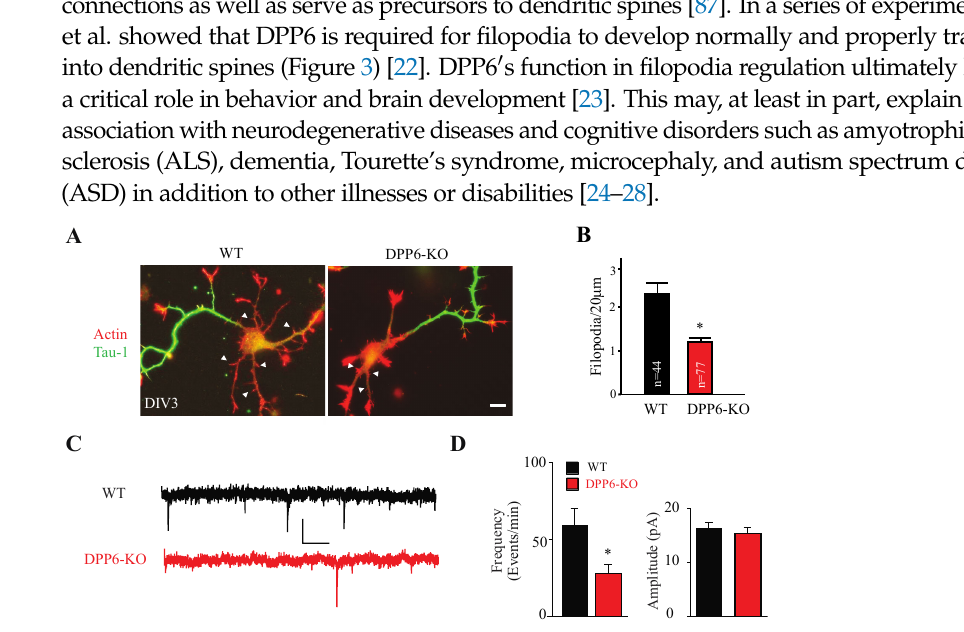
Figure 3. Dendritic filopodia formation is reduced in DPP6 ‐ KO hippocampal neurons and res ‐ cued by DPP6 expression. ( A , B ) DIV3 WT or DPP6 ‐ KO hippocampal neurons visualized for actin filaments with TRITC ‐ phalloidin (red) and for axons with marker Tau ‐ 1 (green). The density of im ‐ mature dendritic filopodia (arrowheads) is decreased in the DPP6 ‐ KO neurons compared to the WT. Scale bars = 10 μ m. ( C ) Sample mEPSC traces from WT and DPP6 ‐ KO cultured hippocampal neu ‐ rons recorded at DIV14 and 15. Scale bars: 10 pA, 250. ( D ) Average mini frequency is decreased in DPP6 ‐ KO versus WT cultured hippocampal neurons, whereas amplitude is not affected. Error bars represent the mean ± SEM. * p < 0.05. From Figures 1 and 3 in Lin et al., 2013 [22]. To show the connection between filopodia and DPP6, Lin et al. [22] first quantified the density of immature dendritic filopodia in cultured hippocampal neurons from DPP6 ‐ KO and WT mice at DIV3. There was a ~45% reduction in DPP6 ‐ KO compared to WT, and a significant decrease in immature dendritic filopodia density (Figure 3A,B). When ex ‐ pressing GFP ‐ tagged DPP6 (DPP6 ‐ GFP), there was a significant increase in immature den ‐ dritic filopodia compared to the expression of GFP alone. To better understand how DPP6 influenced the number of filopodia, they measured filopodia in live imaging experiments. The average life span of existing filopodia was significantly reduced in DPP6 ‐ KO neurons. After transfecting DPP6 ‐ GFP into DPP6 ‐ KO neurons at P0, filopodia stability was rescued. While monitoring the stability of filopodia, the number of new filopodia formed was also counted, showing that DPP6 ‐ KO neurons produce ~60% fewer filopodia than WT neu ‐ rons. Transfecting the DPP6 ‐ KO neurons with DPP6 ‐ GFP increased the formation of new filopodia three ‐ fold compared to the GFP control, effectively rescuing the deficiency. Given that dendritic filopodia transform into dendritic spines, Lin et al. [22] also iden ‐ tified any changes in spine density and function. Using immunofluorescence, they were able to visualize post ‐ synaptic dendritic spines, showing DIV14 cultured DPP6 ‐ KO hip ‐ pocampal neurons had a 30% reduction in dendritic spine density compared to WT. Again, when transfecting DPP6 ‐ GFP at P0, the density of dendritic spines was rescued at DIV14 compared to the GFP control. Recording miniature excitatory post ‐ synaptic cur ‐ rents (mEPSCs) from cultured WT and DPP6 ‐ KO neurons at DIV14 showed no change in the amplitude of mEPSCs, but a decrease in the frequency, confirming DPP6 modulates